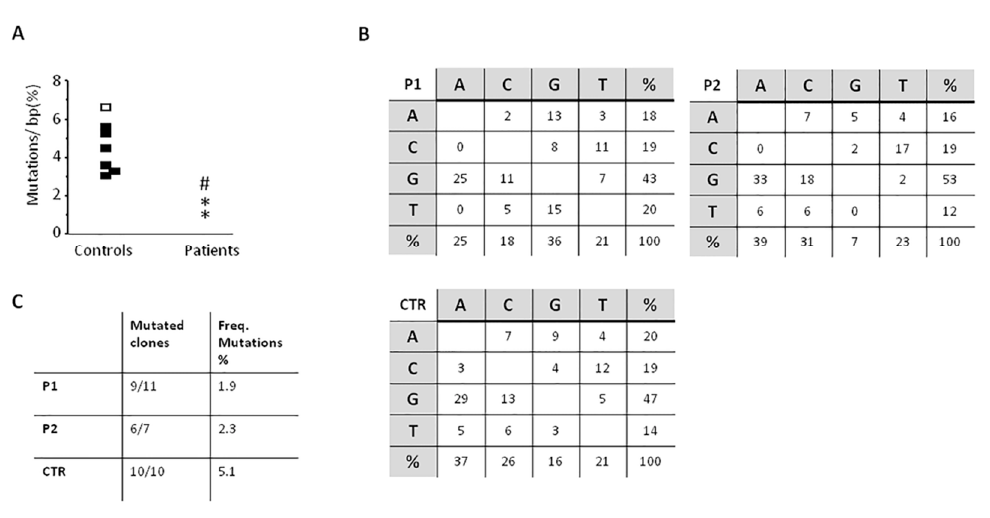
Figure 4. somatic hypermutation (SHM) results on the VH3-23 region of IgM on CD19 + CD27 + isolated B cells. ( A ) Frequency of mutations on IgM + CD27 + B cells purified from controls and patients. Dots represent results for each subject. Controls: Black dots, all 10 clones mutated and white dots, 9 / 10 clones mutated. Patients: P1, * and P2, #; ( B ) Nucleotide substitution pattern for P1 (1st evaluation), P2, and control. The same pattern was observed in P1 in the 2nd evaluation. ( C ) The numbers of mutated clones from all studied clones is shown, as well as the frequency of